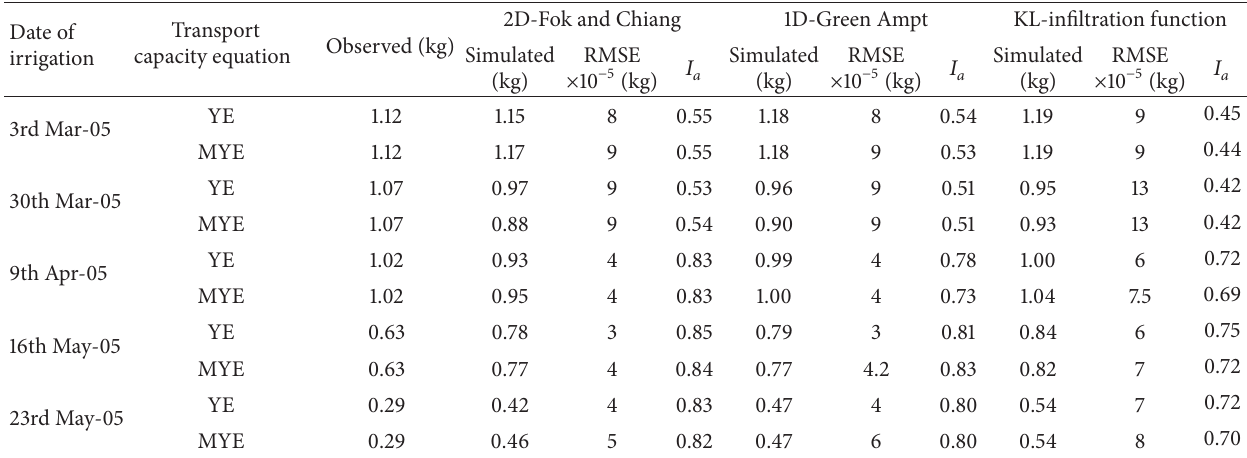
Figure 3: Comparison of observed and simulated sediment load (using MYE) for (a) 6th February 2004 and (b) 17th February 2004 irrigation events. Table 3: Model performance for simulating sediment loss for cropped